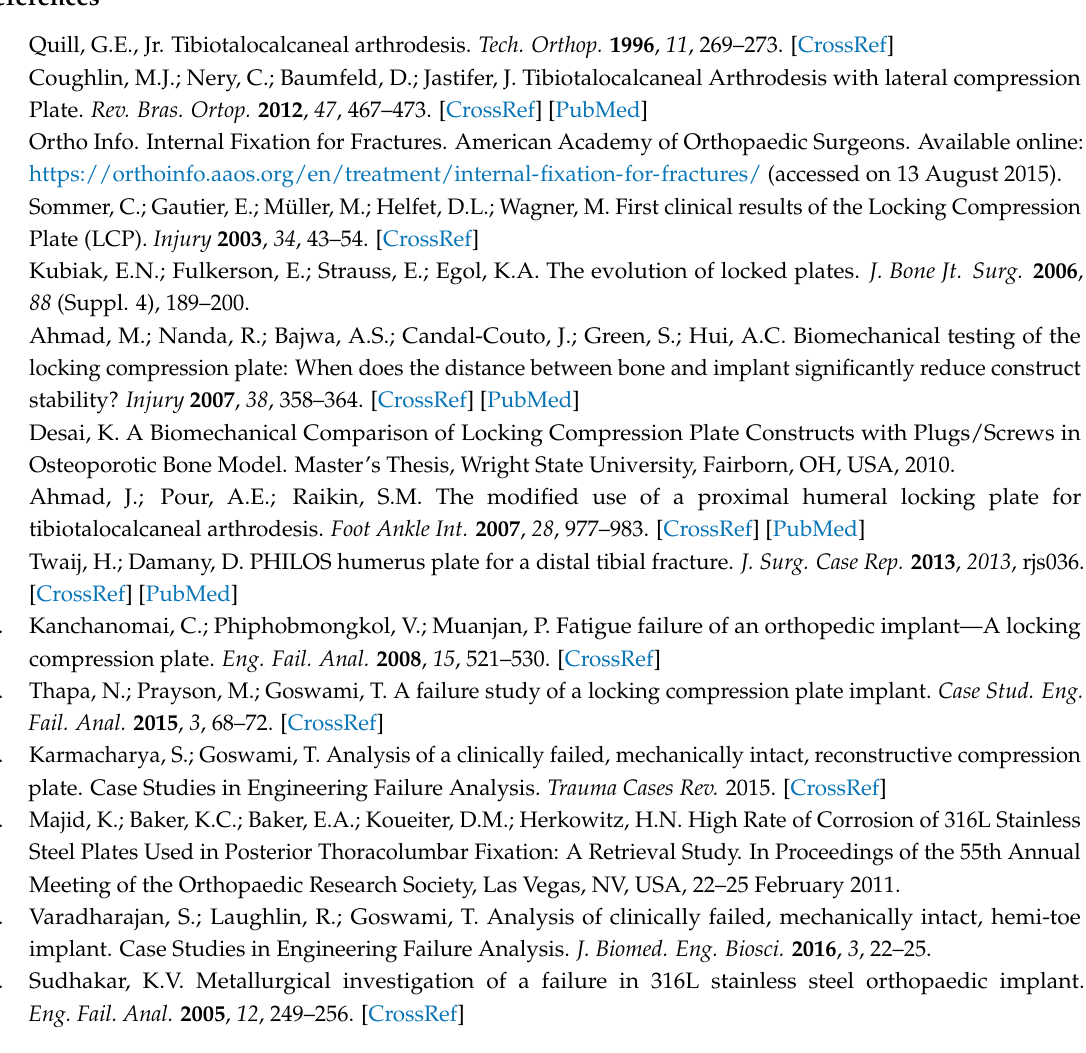
Figure A6. 6 years post-op with an additional fracture in a 3.5 cortical screw in the tibia and the fractured plate became more widely displaced. The valgus deformity seen earlier had now progressed to nearly 30 degrees.